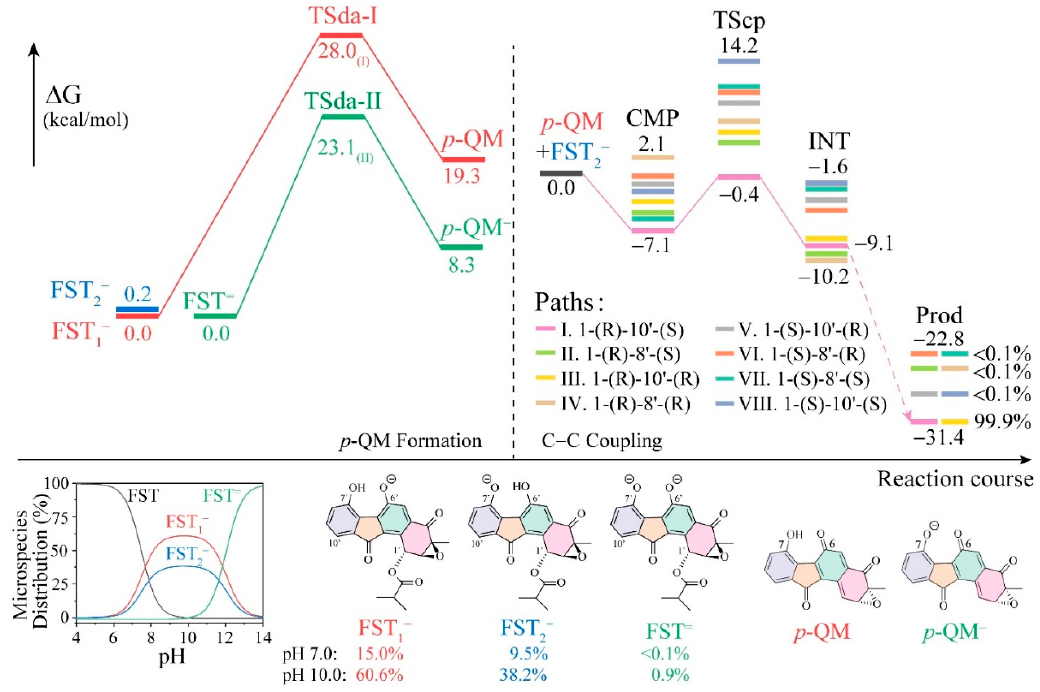
Figure 3. The free energy profile of the p -QM formation and C–C coupling (top), and the conjugated acid-base microspecies distribution (bottom).